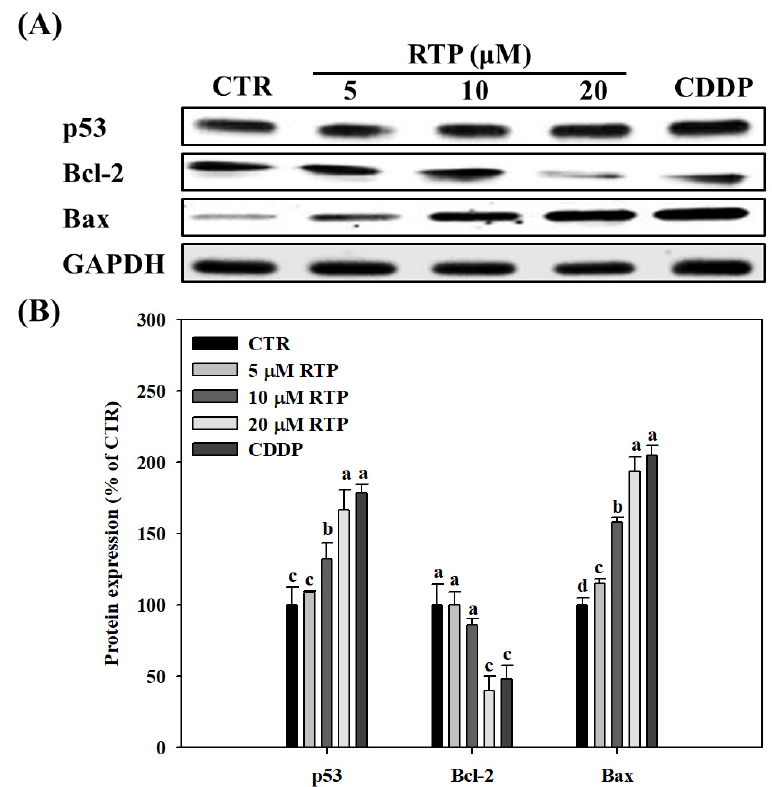
Figure 4. Effects of rutaecarpine (RTP) on expression of p53, Bcl-2, and Bax proteins in human esophageal squamous cells CE81T/VGH. Cells (1 × 10 5 cells/mL) were treated with RTP (5, 10, and 20 µ M) or cisplatin (CDDP; 5 µ M) for 72 h. ( A ): Western blots of p53, Bcl-2, and Bax proteins and glyceraldehyde-3-phosphate dehydrogenase (GAPDH). ( B ): Densitometric analysis of Panel A. CTR represents the control group. Values (mean ± SD, n = 3) not sharing a common lower case letter in each protein expression are significantly different ( p < 0.05).